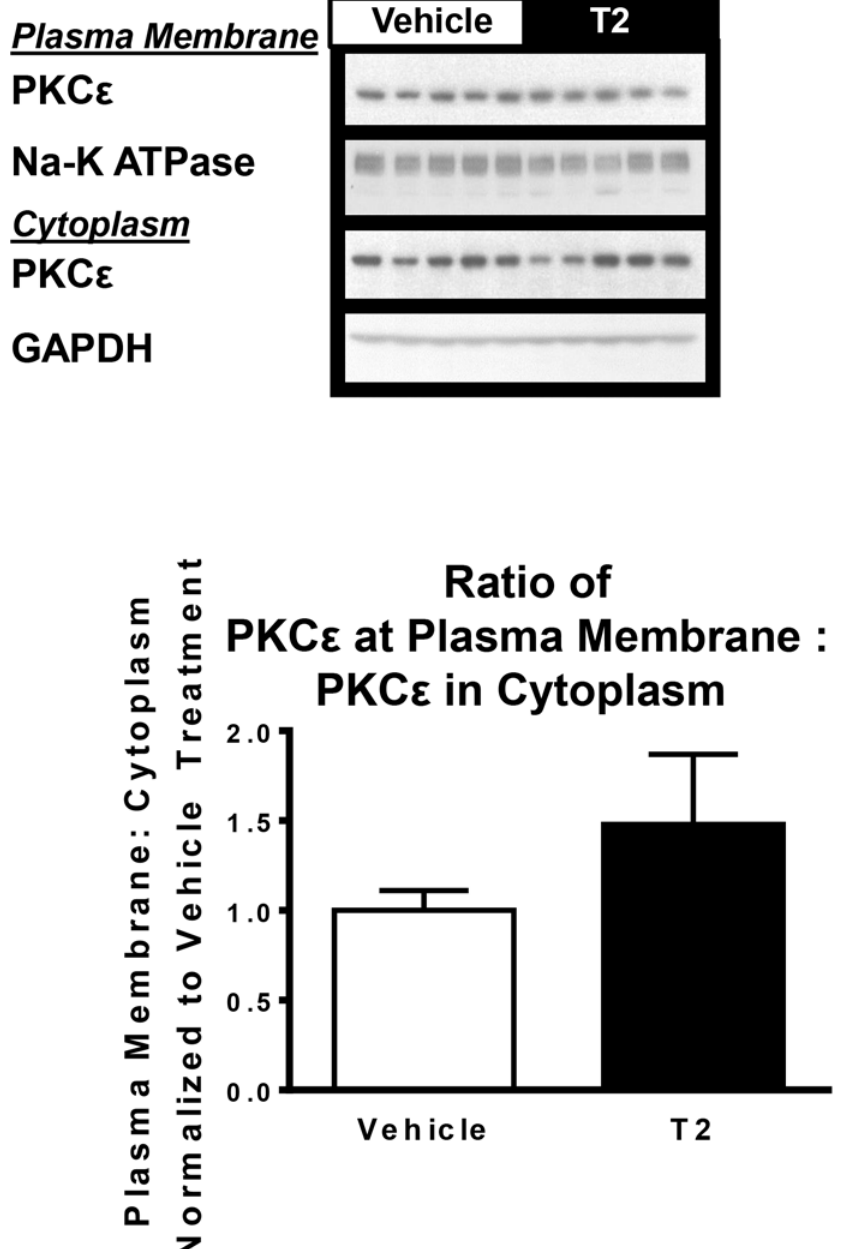
Fig 3. Hepatic PKC ε translocation between cytoplasm and plasma membrane. Assessed by Western blot. Plasma membrane PKC ε abundance normalized to sodium potassium ATPase, cytoplasmic PKC ε abundance normalized to glyceraldehyde 3 phosphate dehydrogenase (GAPDH). Ratio between plasma membrane and cytoplasm PKC ε was determined for all samples, this ratio for all samples was normalized to the average ratio in the vehicle treated group. ( n = 5 per